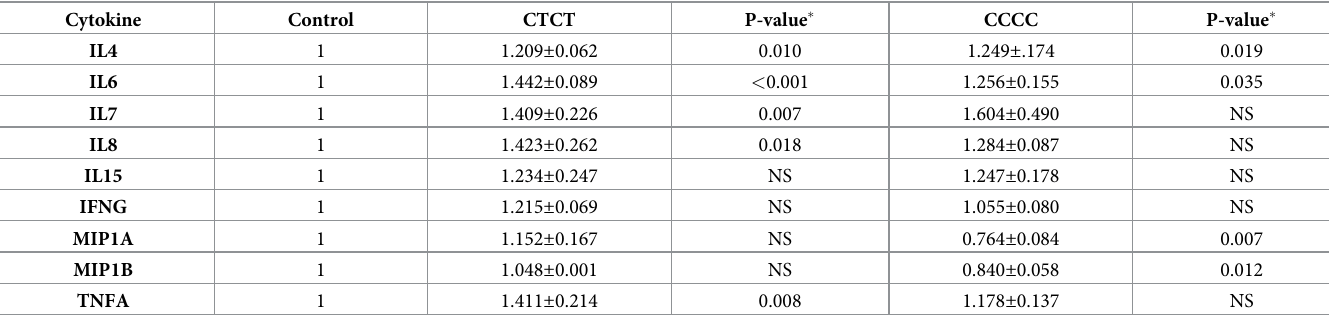
Table 1. Cytokine concentration after PTGDR variants transfection in A549 cells.